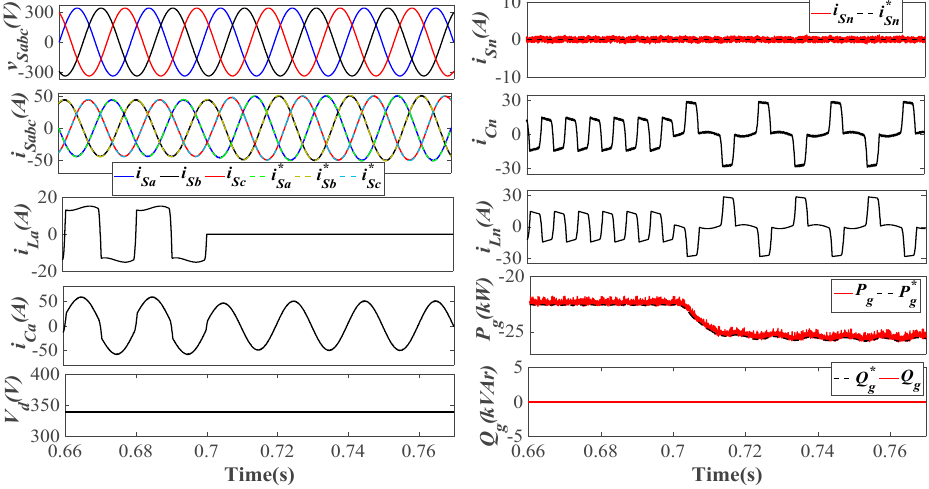
Figure 14. Unbalanced load analysis of (cid:1874) (cid:3020)(cid:3028)(cid:3029)(cid:3030) , (cid:1861) (cid:3020)(cid:3028)(cid:3029)(cid:3030) , (cid:1861) (cid:3013)(cid:3028) , (cid:1861) (cid:3004)(cid:3028) , (cid:1848) (cid:3031) , (cid:1861) (cid:3020)(cid:3041) , (cid:1861) (cid:3004)(cid:3041) , (cid:1861) (cid:3013)(cid:3041) , (cid:1842) (cid:3034) (cid:1853)(cid:1866)(cid:1856) (cid:1843) (cid:3034) . Figure 14. Unbalanced load analysis of v Sabc , i Sabc , i La , i Ca , V d , i Sn , i Cn , i Ln , P g and Q g